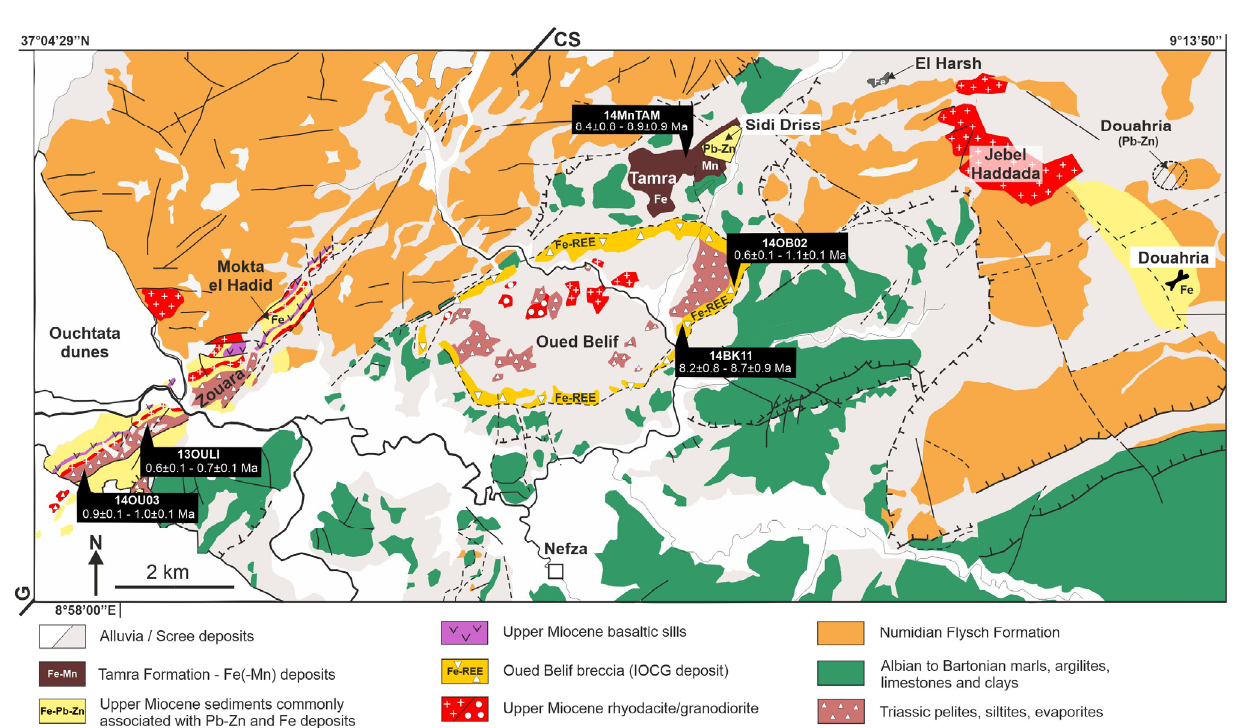
Figure 2. Simplified geologic map of the Nefza-Sejnane district, Tunisia (modified after reference [5], showing the location and (U-Th)/He corrected ages of the supergene goethite. G-CS = Ghardimaou Cap Serrat sinistral fault zone.